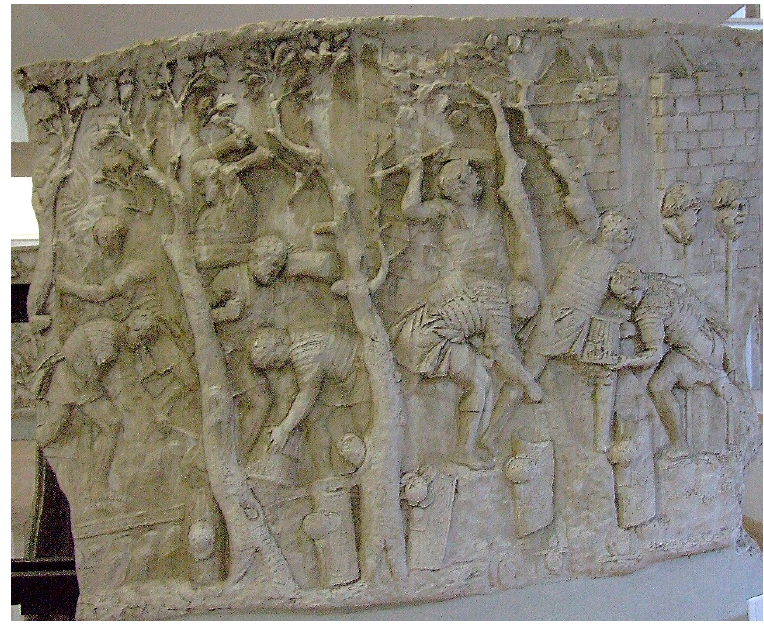
Figure 4. Roman soldiers felling trees for construction purposes. From: Trajan’s Column. Source: Wikimedia commons.